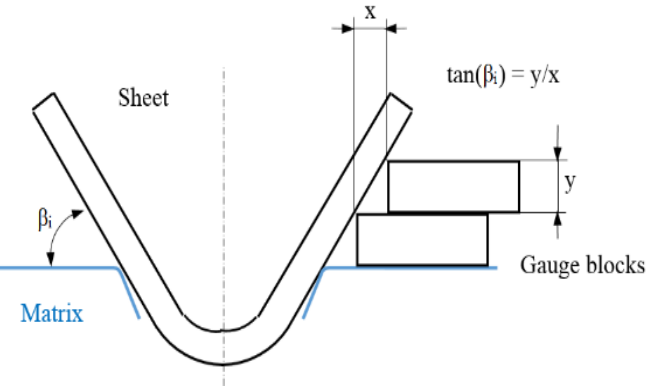
Fig. 7. The initial angle α i during loading.